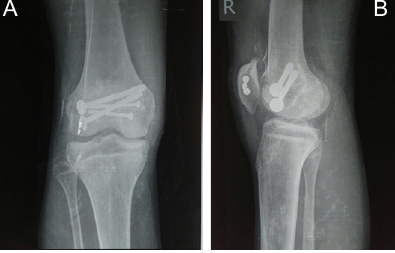
Figure 2. Post-operative X-ray (A) AP view and (B) lateral view of knee joint. A